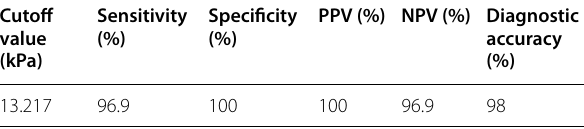
Table 6 Cutoff values of SWE (kPa) for AIT and Sensitivity, Specificity, PPV, NPV and diagnostic accuracy of these cutoff value